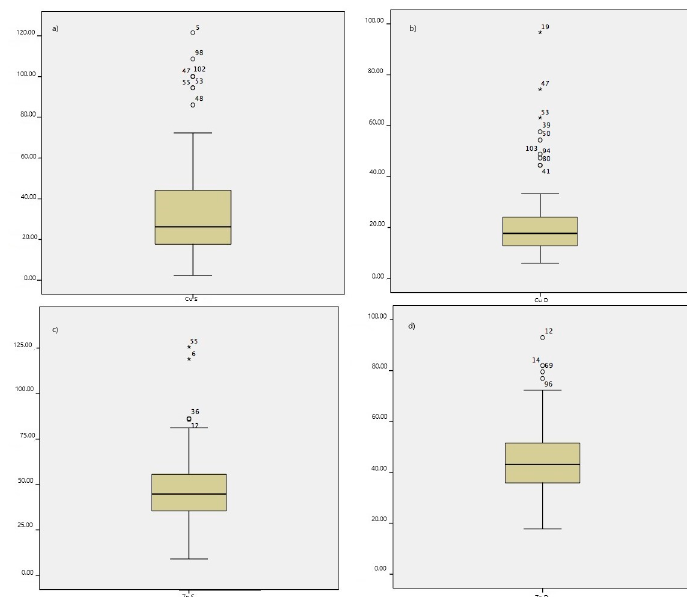
Figure 4. Boxplot of total metal Cu ( a ) surface and ( b ) depth and Zn ( c ) surface and ( d ) depth. The reference values calculated were 85.28 mg kg –1 at the surface and 48.88 mg kg –1 at depth for Cu, and they were calculated as 83.69 mg kg –1 at the surface and 72.05 mg kg –1 at depth for Zn.